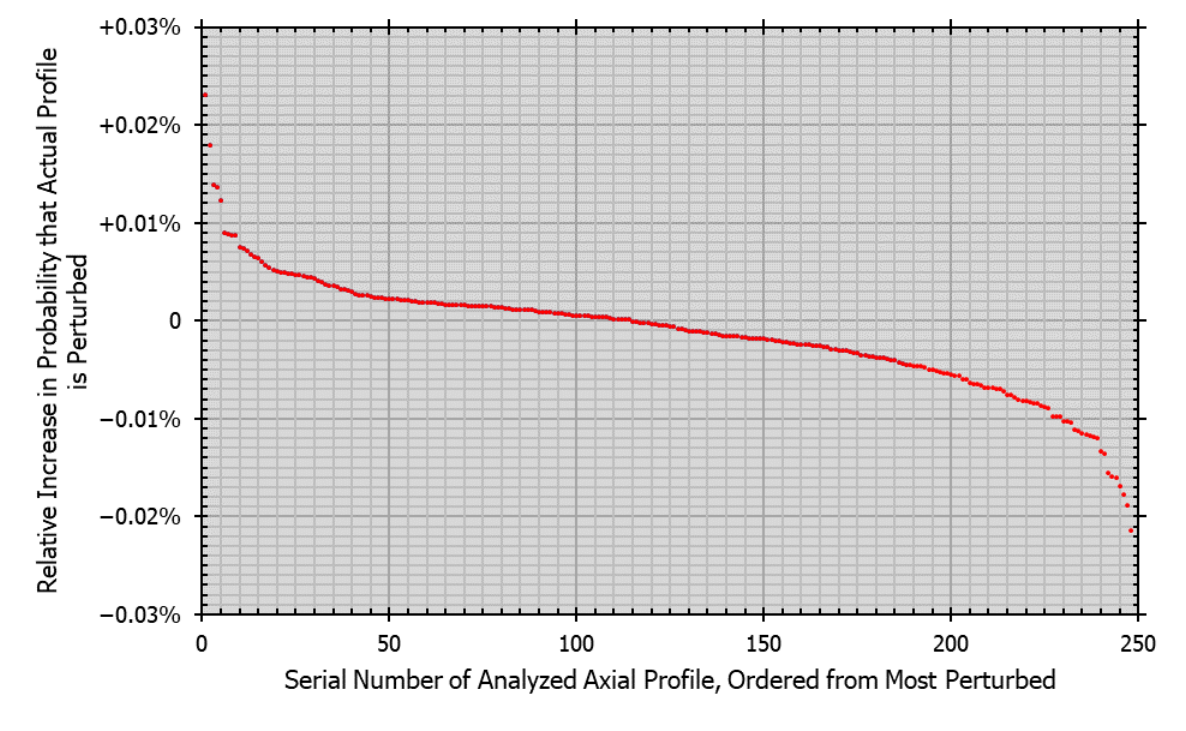
Figure 6. Probability of a True Perturbation in Each Evaluated Axial